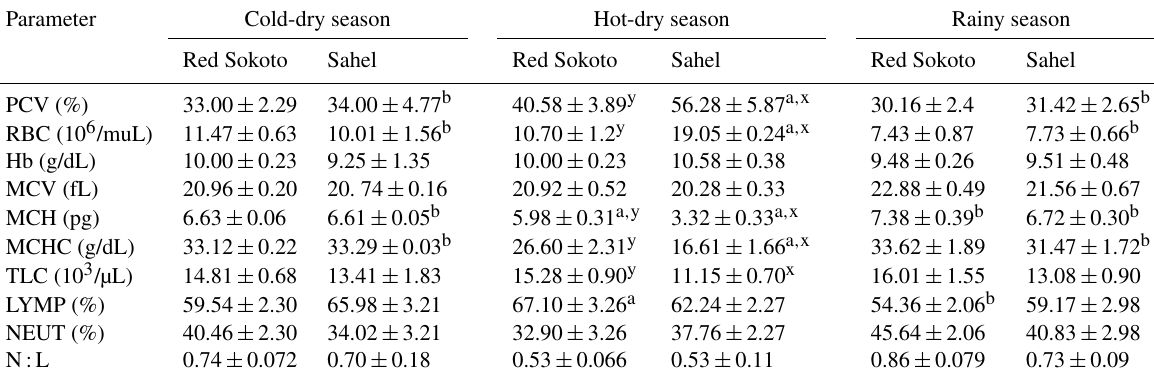
Table 2. Effect of season on haematological parameters of Red Sokoto and Sahel buck kids.